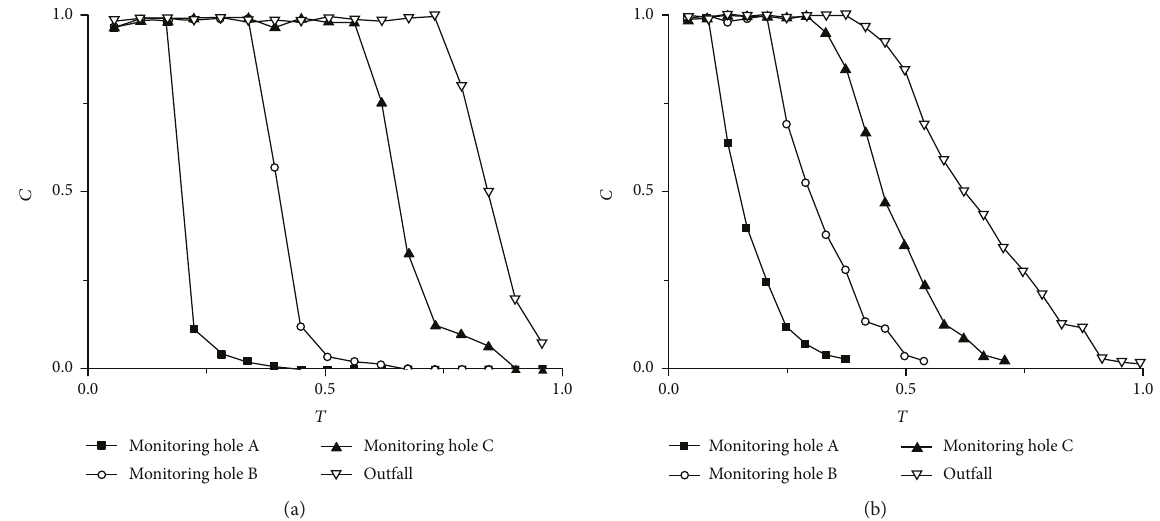
Figure 5: The dimensionless variation curve when the water injection rate is 5mL/min: (a) gravity direction and (b) reverse gravity